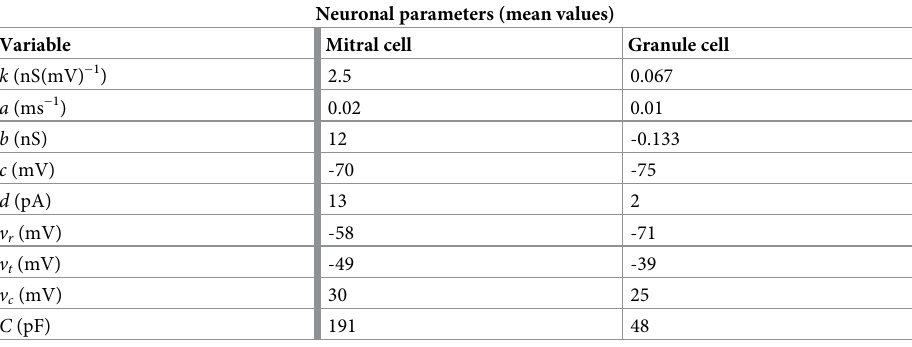
Table 3. Mean values of the neuronal parameters in the anatomically detailed